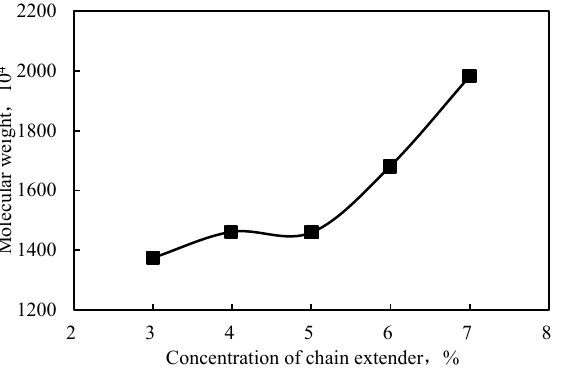
Figure 7. Relationship between the chain extender concentration and the polymer’s molecular weight.